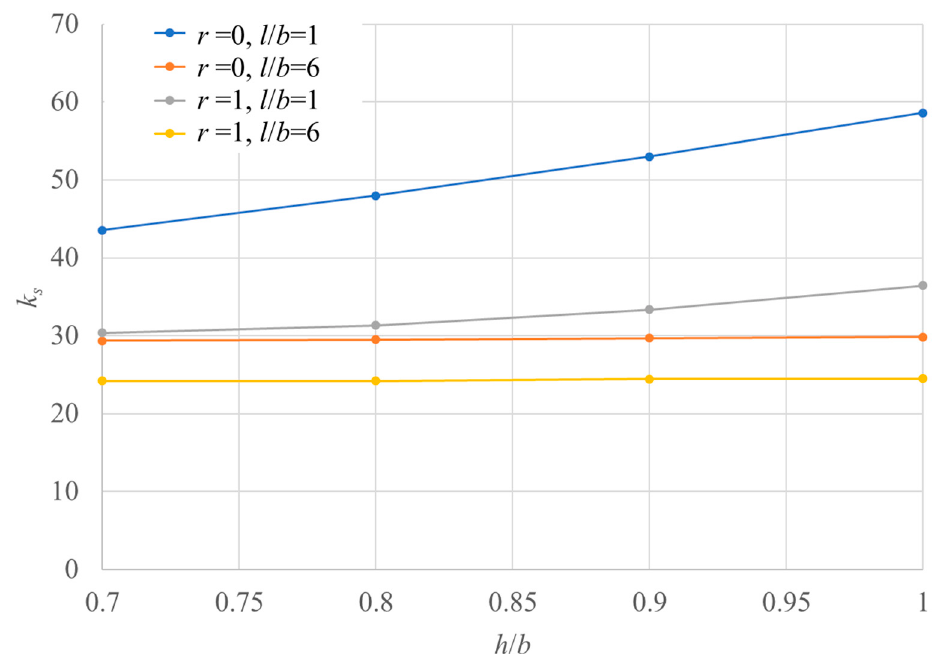
Figure 8. k s versus h / b .